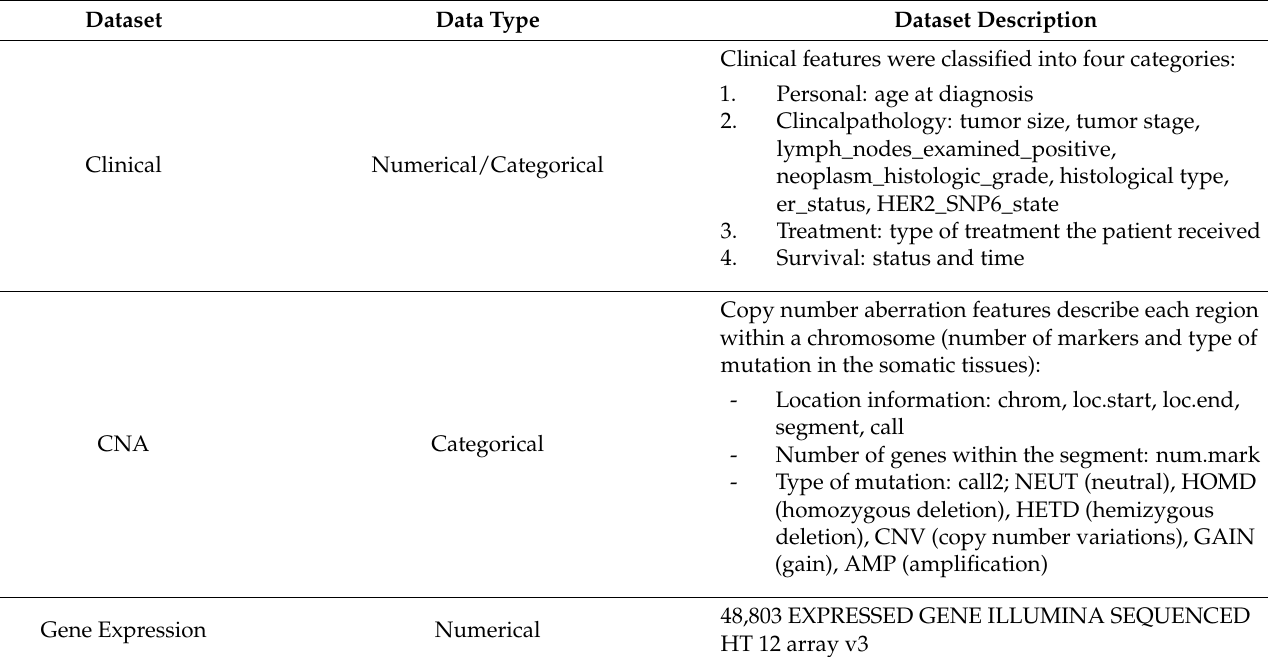
Table 7. METABRIC dataset description.